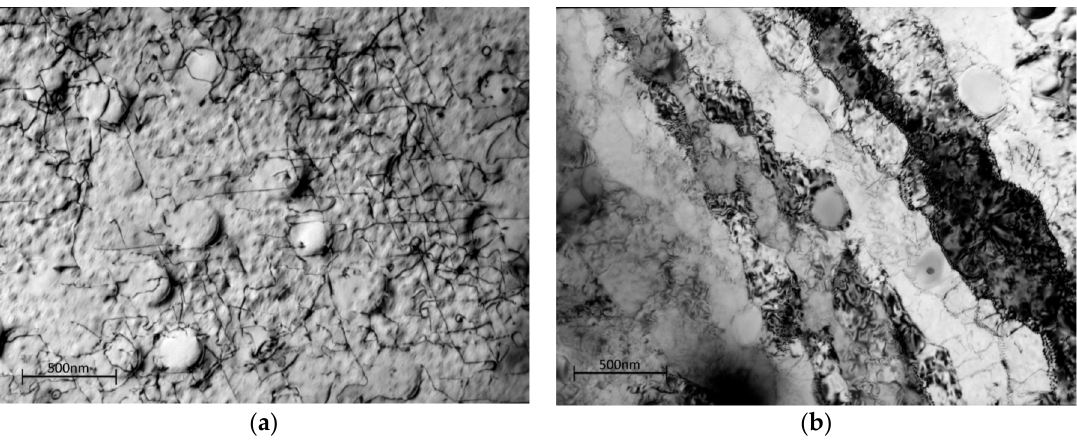
Figure 10. Dislocation structure in Waspaloy subjected to loading to 0.2% proof stress in the ( a ) grains; ( b ) grain boundary zones (bright field images). Table 3. Time to minimum creep rate and associated strain for the range of stress conditions. Applied Stress (MPa) Time to Minimum Creep Rate (h)